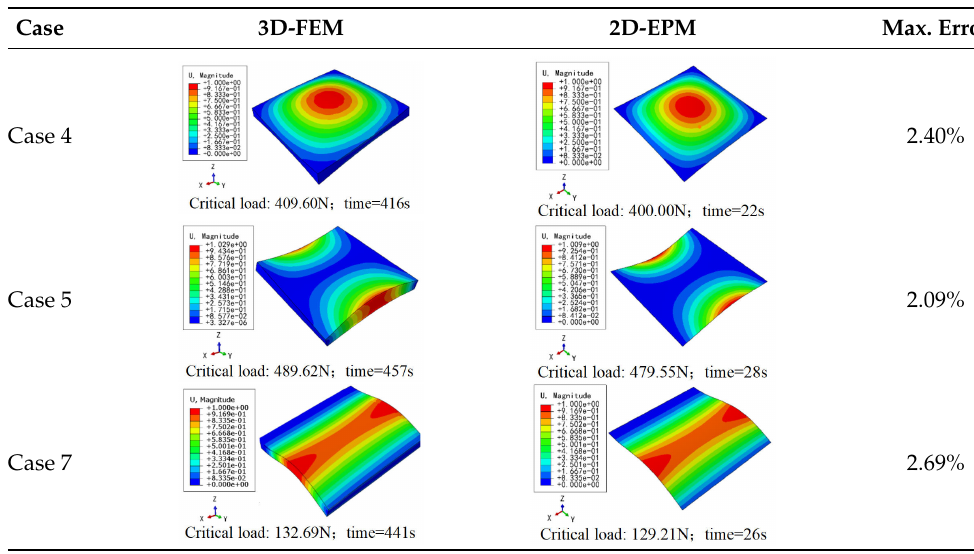
Table 9. Comparison of the first buckling modes and critical loads (N) of 3D-TCP in different cases predicted by two